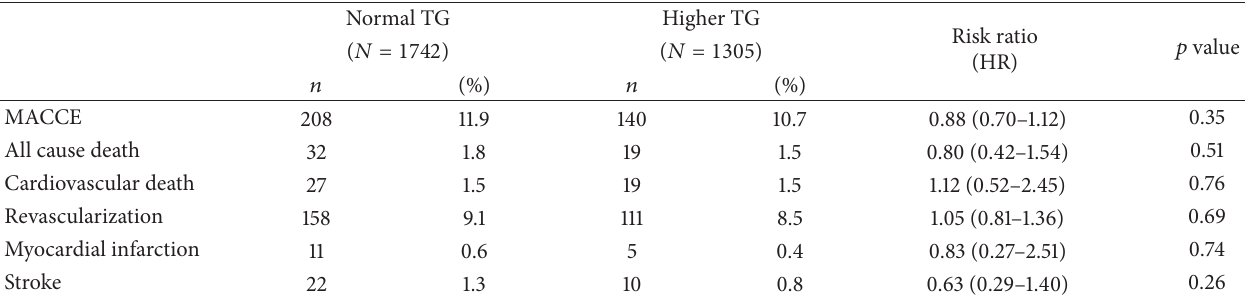
Table 3: The comparison of cardiovascular events between normal TG group and elevated TG group. Normal TG Higher